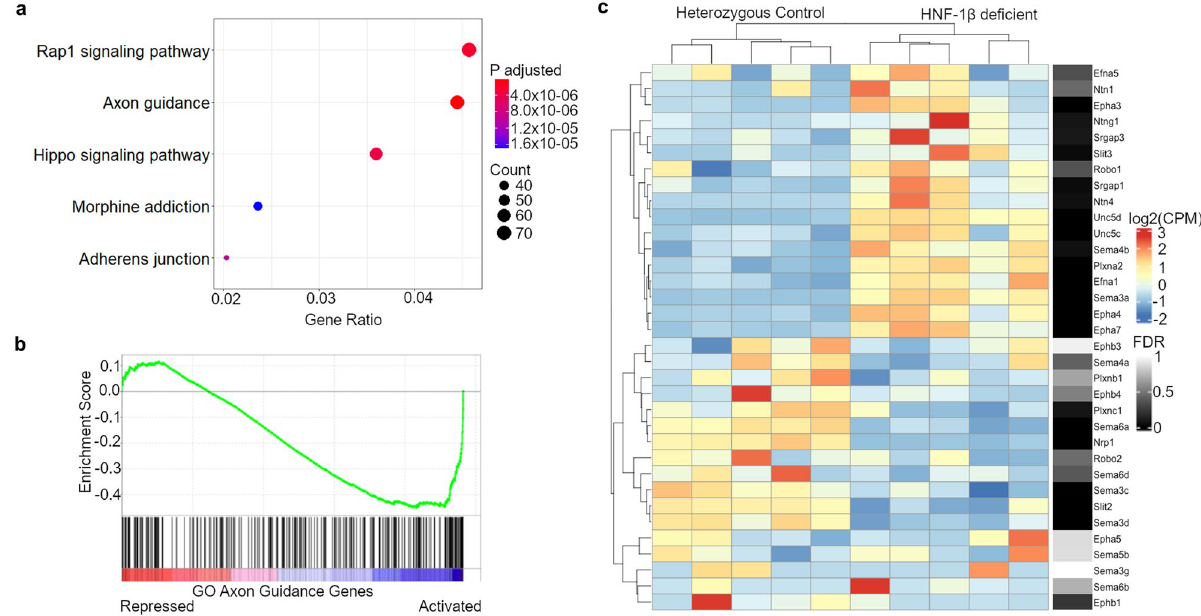
Figure 4. Axon guidance genes are regulated by HNF-1β in the developing ureteric bud. ( a ) Pathway analysis of HNF-1β gene targets identified by ChIP-seq in E14.5 mouse kidneys. ( b ) Gene set enrichment analysis (GSEA) showing that axon guidance is negatively enriched (Enrichment score = − 0.45, FDR adjusted p = 0.0) in HNF-1β-deficient ureteric bud (UB) cells compared to heterozygous control UB cells. ( c ) Heatmap showing expression (blue to red) of HNF-1β-regulated axon guidance genes in heterozygous control UB cells compared to versus HNF-1β-deficient UB cells, FDR p-values shown in